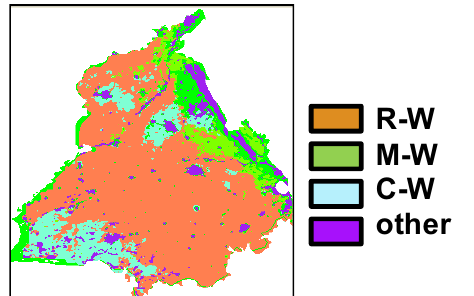
Figure 2: Cropping system map of Punjab (Source: Panigrahy et